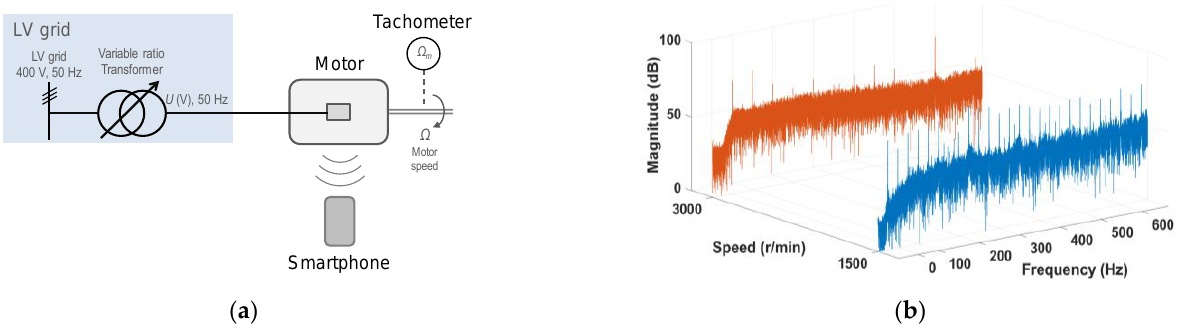
Figure 10. No load coupled to the motor shaft: ( a ) the test configuration; ( b ) the spectra of the motor noise signals.